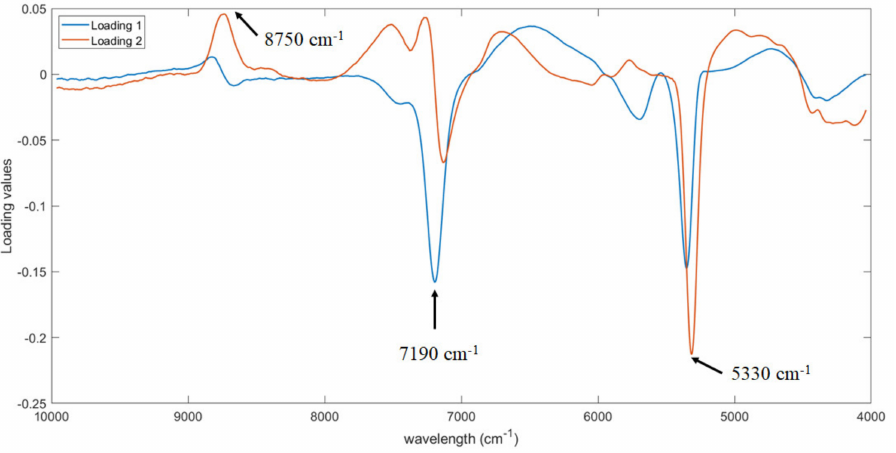
Figure 5. First two loadings of Partial Least Squares Regression (PLS) model for the prediction of soluble solid